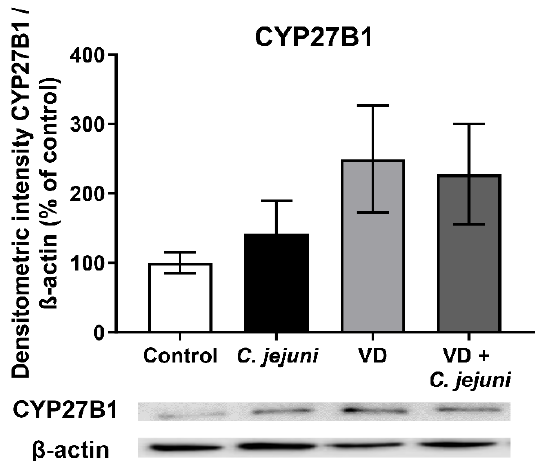
of their DNA transcripts, as predicted by IPA in the RNA-Seq data from the colon muco- sae of C. jejuni -infected patients (Figure 1).